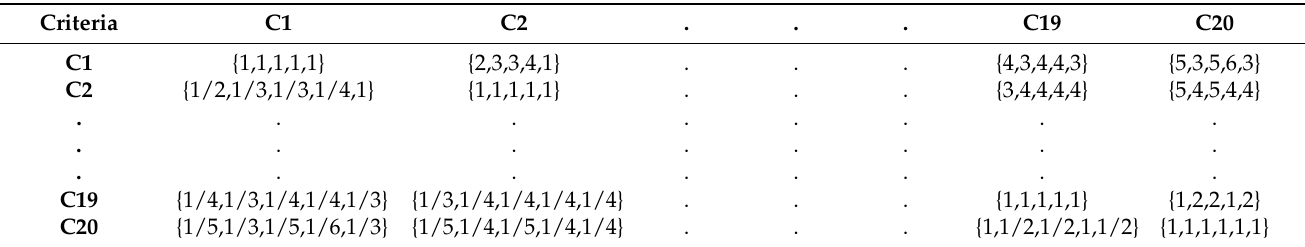
Table 4. Integrated comparison